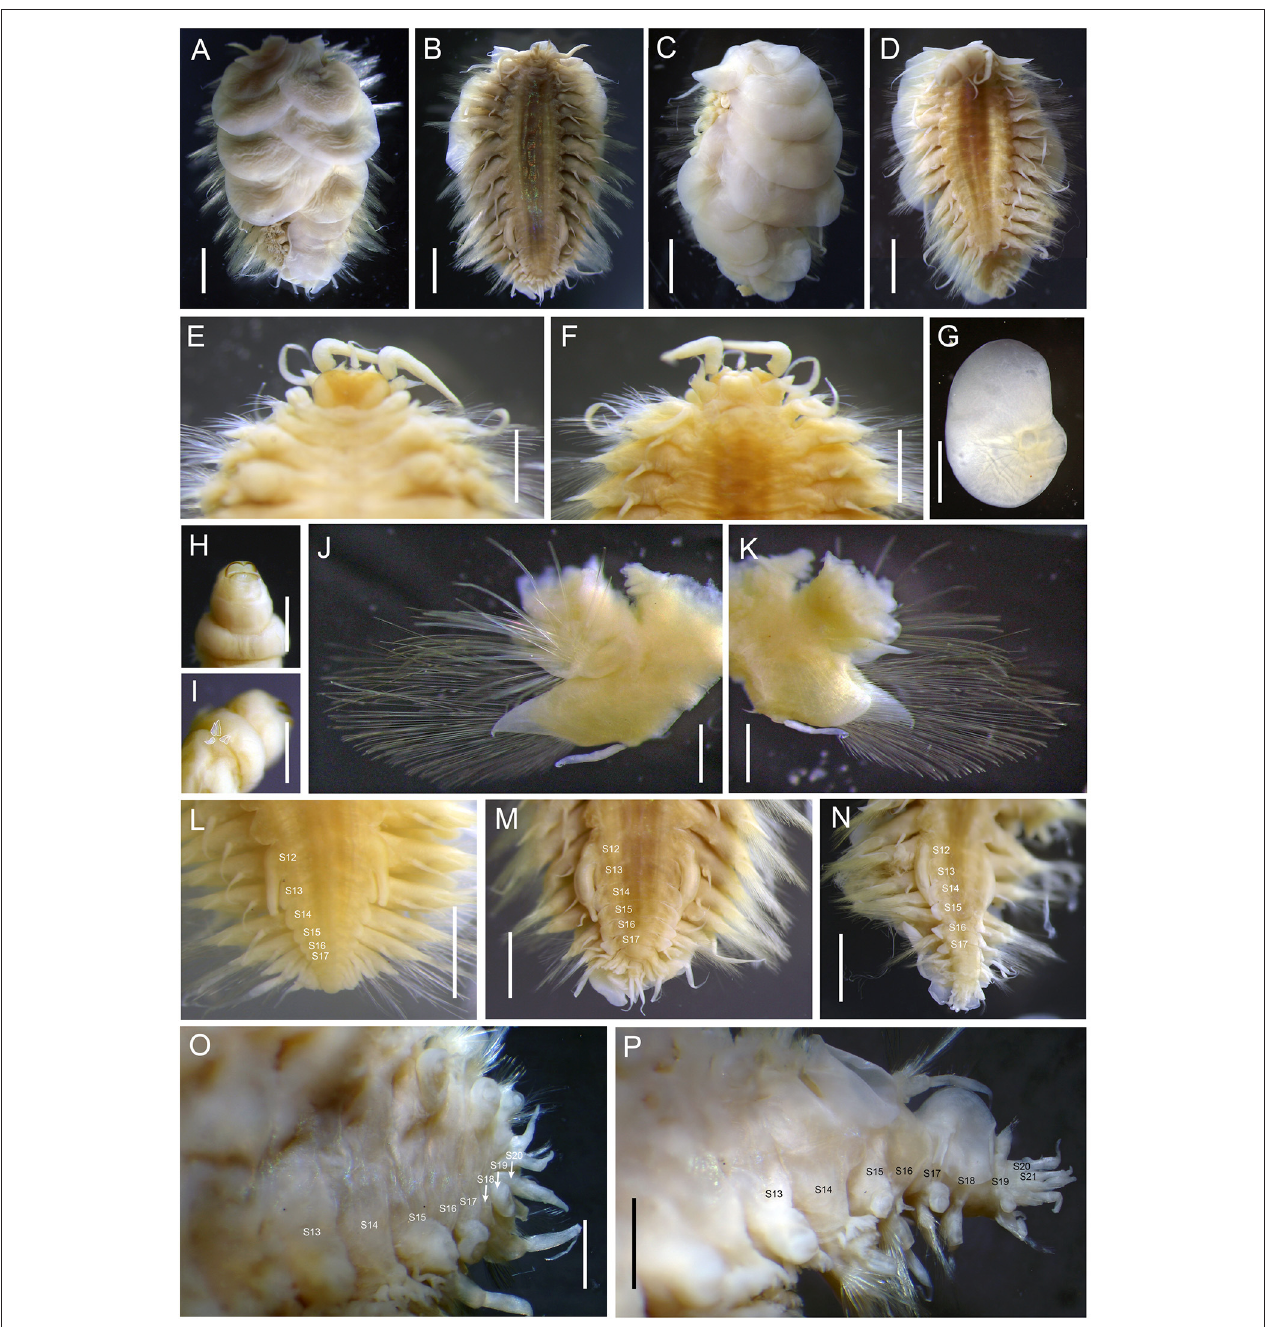
FIGURE 3 | Branchinotogluma japonicus . (A,B,M,O) , Specimen 3; (C,D,H,I) allotype; (E–G) , Specimen 1; (L) Specimen 13; (J,K,N,P) Specimen 2. (A) dorsal view of male. (B) ventral view of male. (C) dorsal view of female. (D) ventral view of female. (E) dorsal view of anterior part. (F) ventral view of anterior part. (G) elytra. (H) ventral view of extended pharynx. (I) five papillae on the lateral side of pharynx (one side). (J) anterior view of parapodium (segment 10). (K) posterior view of parapodium (segment 10). (L–N) , ventral view of posterior part of males. (O) dorsal view of (M) . (P) dorsal view of N. Scale bar: (A–D) 1mm; (E,F,G,L,M,N) 1mm; (H–K) , (O,P) 0.5mm.